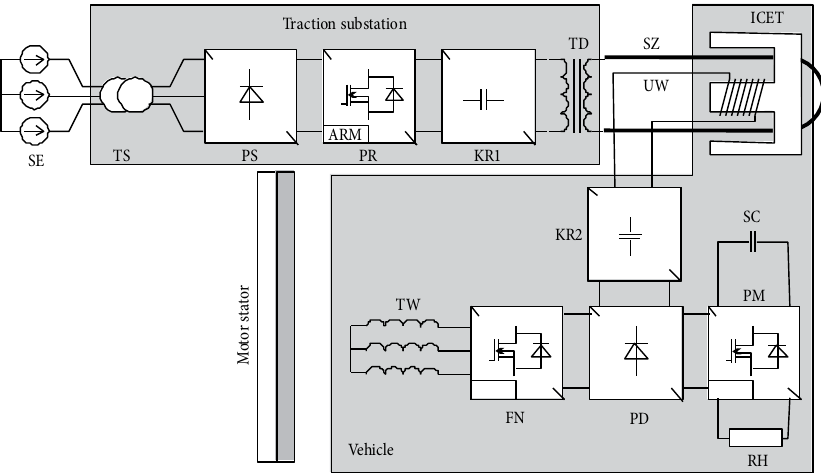
Fig. 5. The structure of power circuits and vehicle